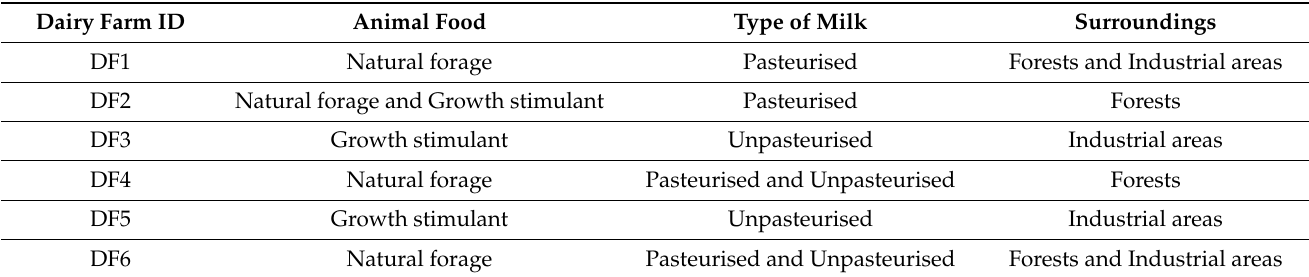
Table 1. Example DF